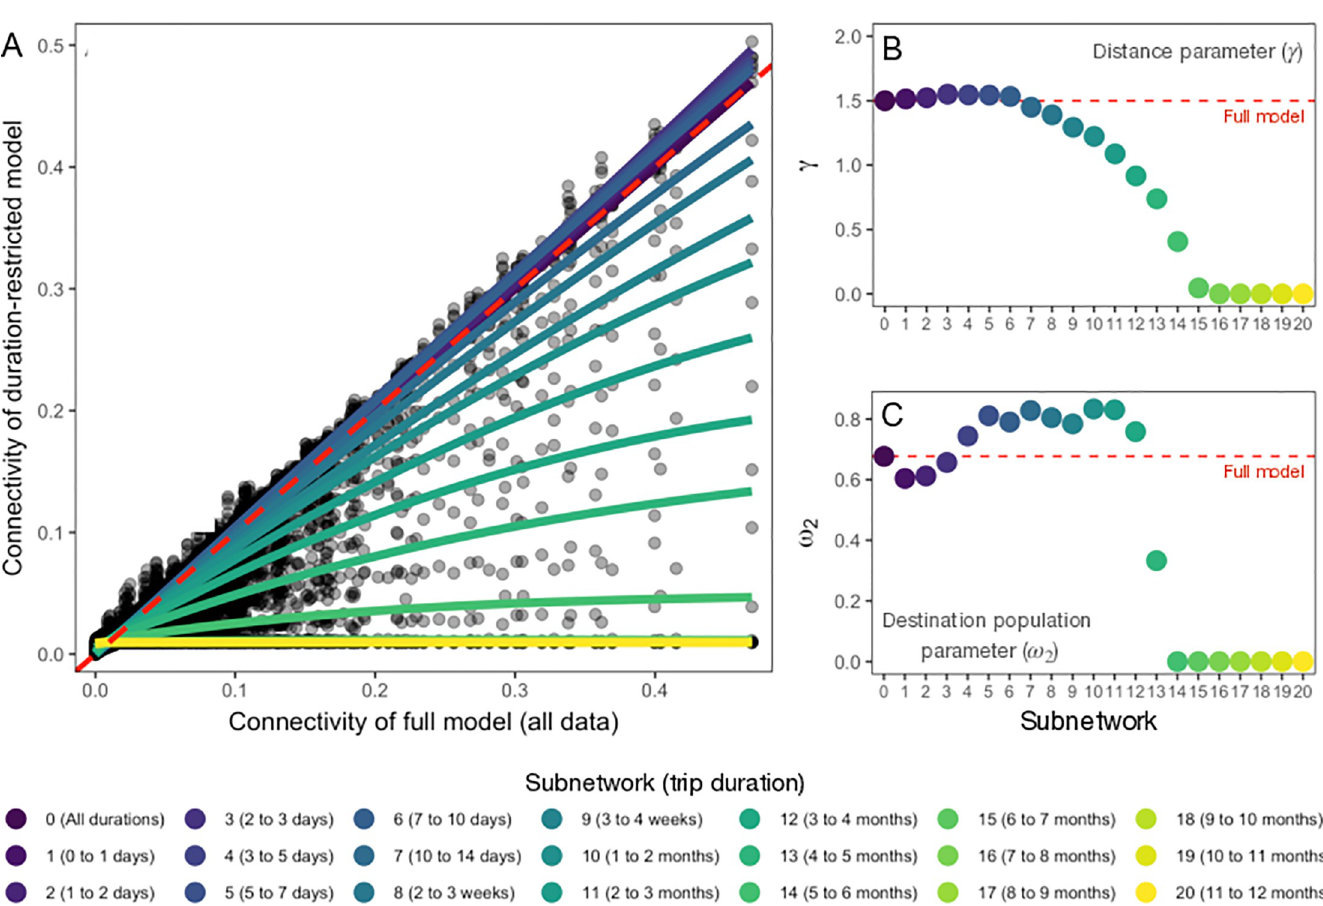
Fig 5. Change in connectivity and gravity model parameters fitted to travel data with increasing duration intervals compared to full model. A) The distribution of connectivity values for duration-restricted models (y-axis) in comparison to the full model that includes all data (x-axis). The smoothed lines indicate the change in connectivity for duration-restricted models with larger duration intervals showing a more evenly distributed pattern across all locations compared to the null model. The dashed red line indicates connectivity values that are equal to the full model. In B) and C), the change in fitted gravity model parameters (distance parameter γ and destination population parameter ω 2 respectively) for increasing trip duration intervals. The color gradient indicates the duration interval of each model and the dashed red line shows the fitted parameter value for the full model, which includes all trip durations.